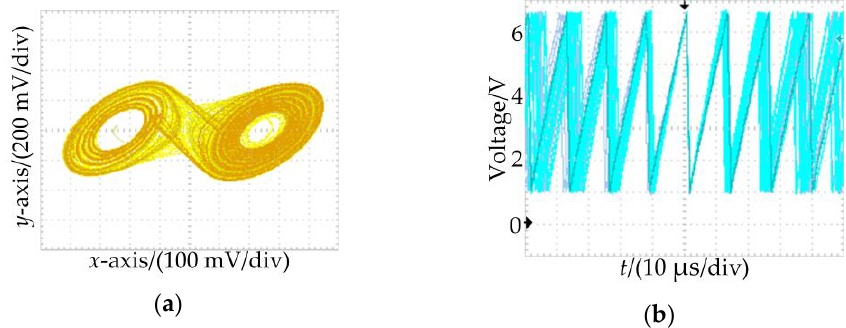
Figure 12. Chaotic spread spectrum: ( a ) Chaotic attractor and ( b ) Sawtooth waveform.